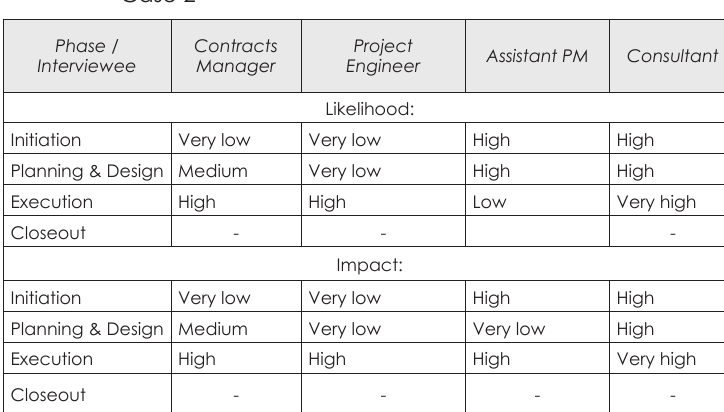
Perceptions regarding project risk P-I across the PLC in Case